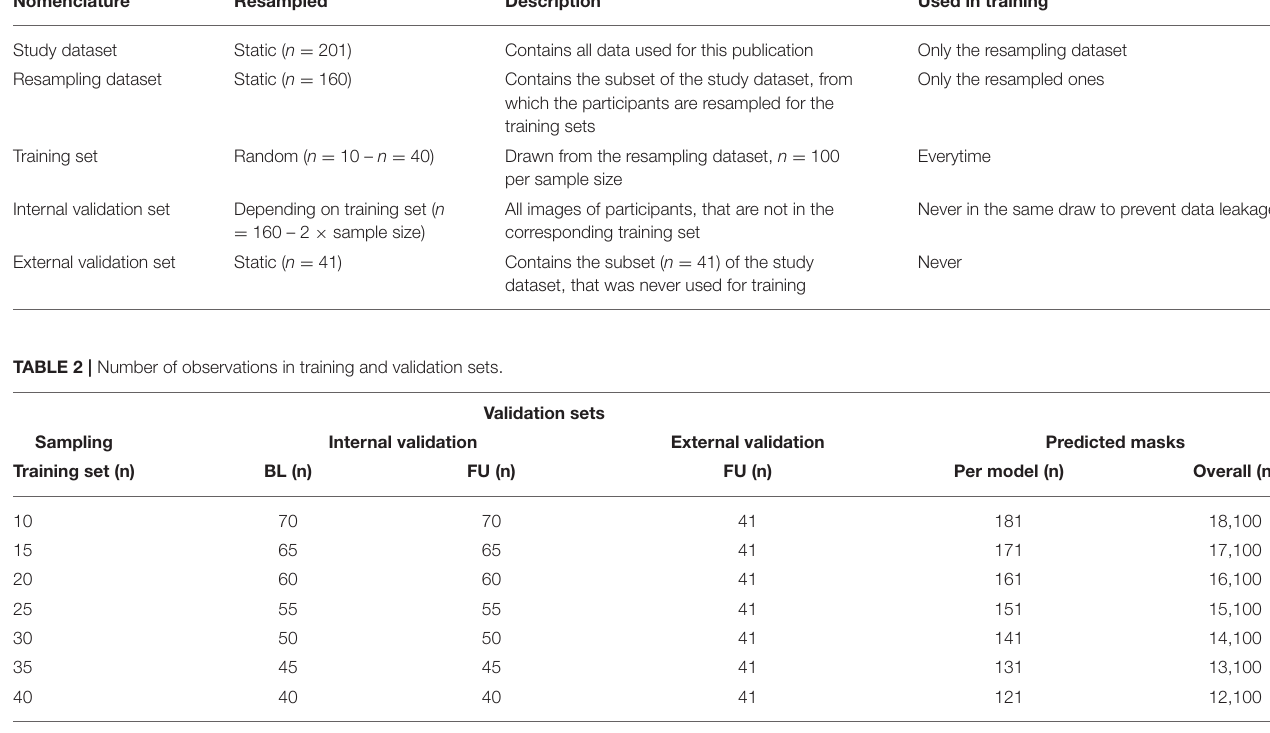
Frontiers in Aging Neuroscience |